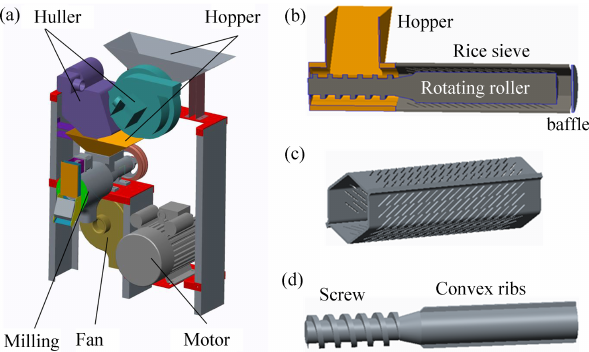
Figure 1. (a) Diagram of a rice mill machine. (b) The cross-section profile of the milling chamber. (c) A hexagonal rice sieve. (d) A rotating roller consisting of a screw and two symmetrical convex ribs.